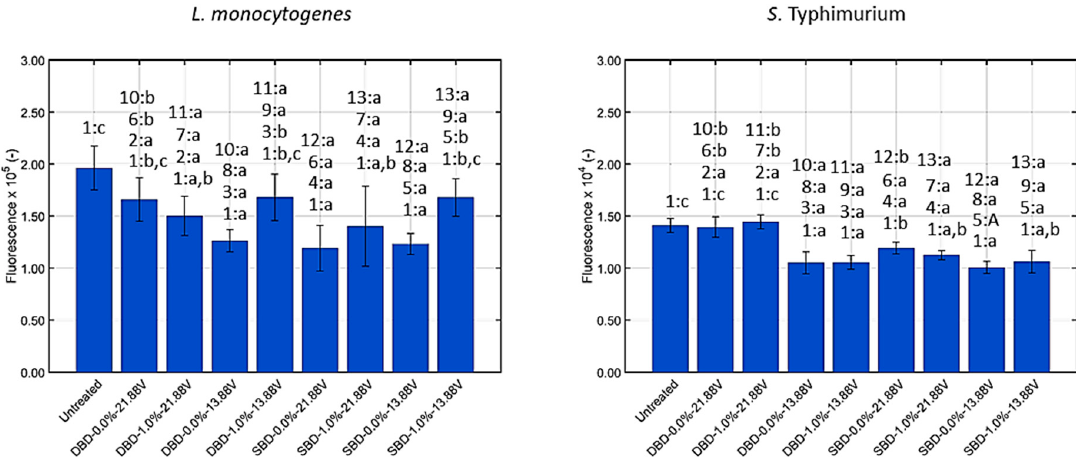
Figure 8. Fluorescence measurements (-) obtained following interaction of SYBR Green I with the CAP treated and digested Listeria monocytogenes and Salmonella Typhimurium biofilm-associated cells ( n = 3). Significant di ff erences between all examined conditions (ANOVA test 1), including the untreated control, have been indicated by means of a di ff erent small letter, with ‘a’ bearing the lowest value. The influence of the oxygen level (ANOVA tests 2–5), the electrode configuration (ANOVA tests 6–9), and the discharge power (ANOVA tests 10–13) have been indicated as well by means of a di ff erent small letter, with ‘a’ again bearing the lowest value. Separate ANOVA tests were again performed for each biofilm forming species.